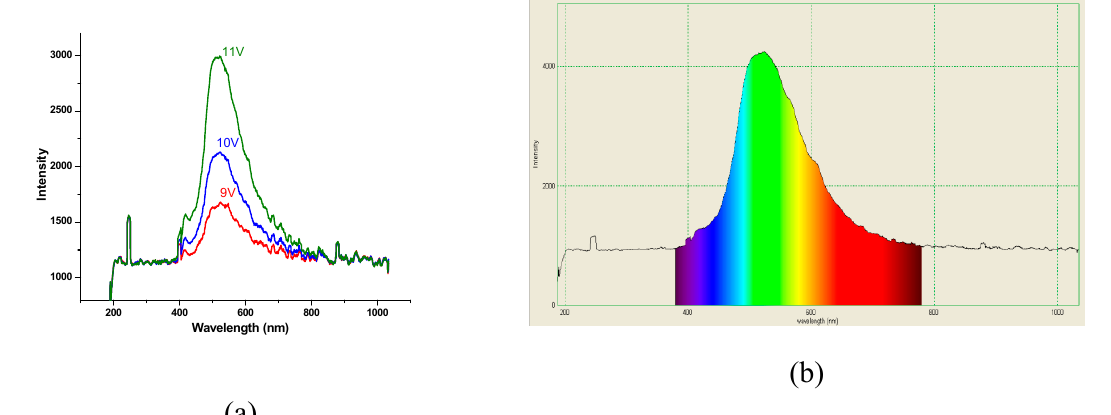
Figure 8. Electroluminescence spectra of light emitting diodes based on organic materials (OLED) devices (ITO/PEDOT:PSS/POF/Ga–In) ( a ) when excited with 9, 10, and 11 V (sample 1 in supporting information); ( b ) measured at 11 V (sample 5 in supporting information).